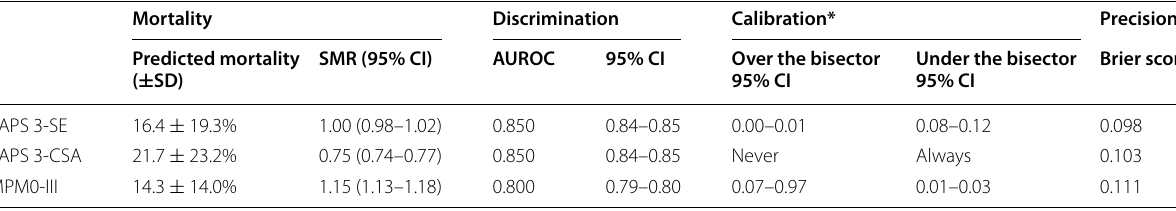
Table 3 Scores performances comparison